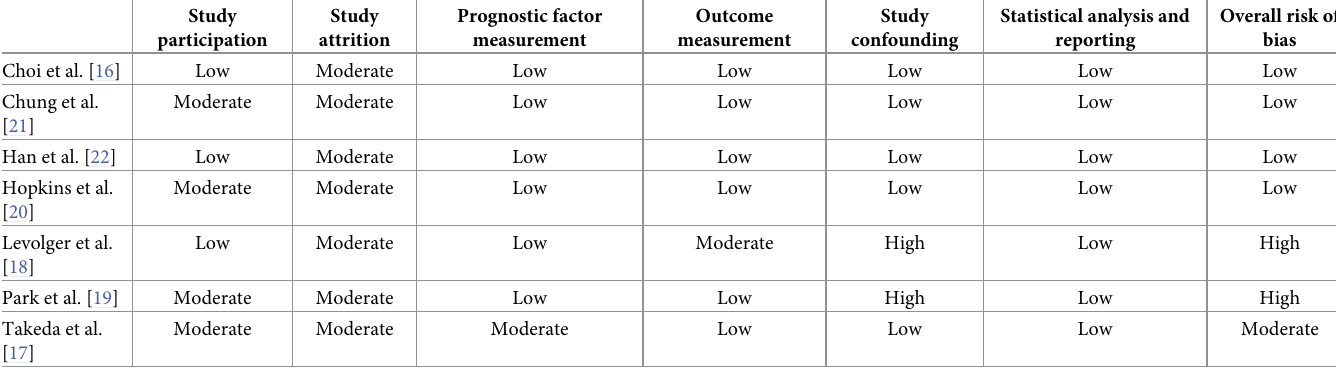
Table 2. Risk of bias for the included studies assessed by the Quality in Prognosis Studies (QUIPS) tool.